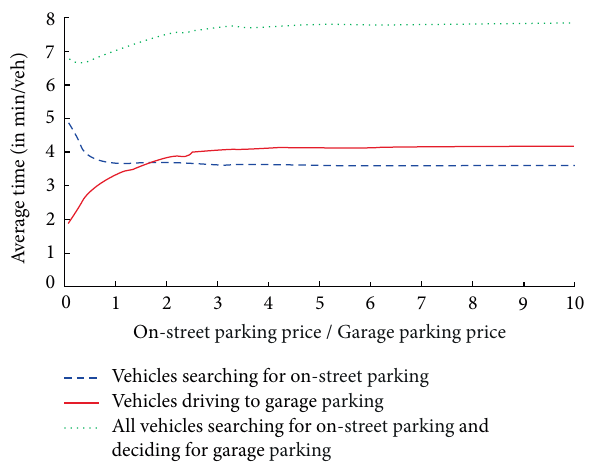
Figure 10: The impact of on-street and garage parking pricing schemas on average time searching/driving to garage